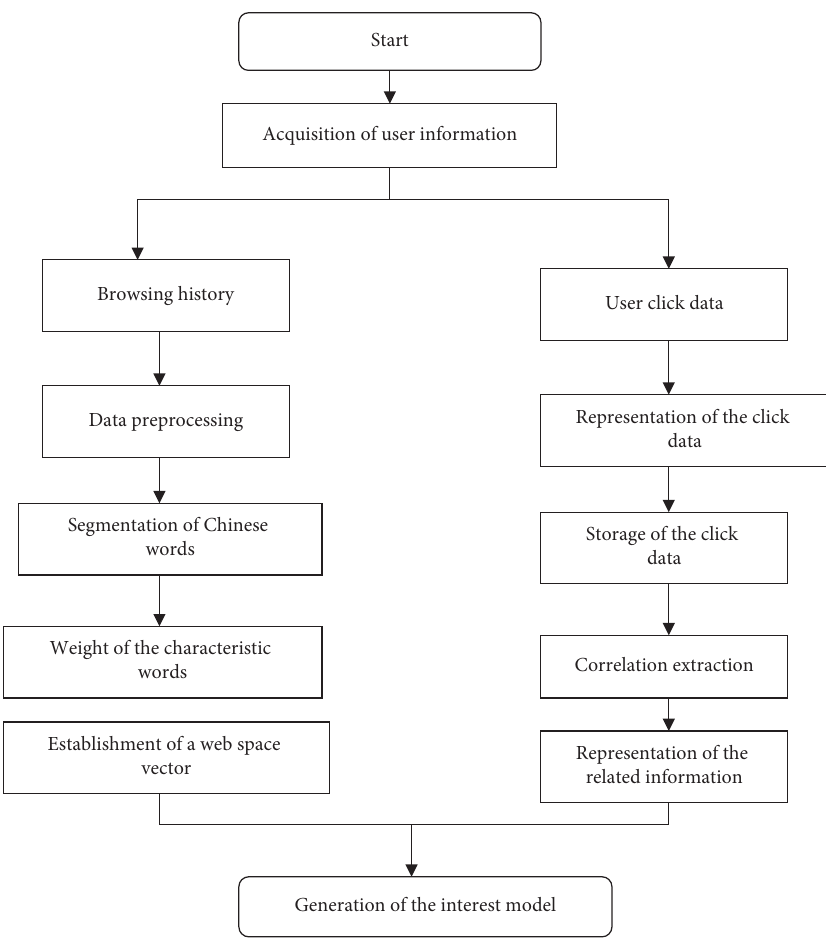
Figure 1: Design process for the establishment of the user